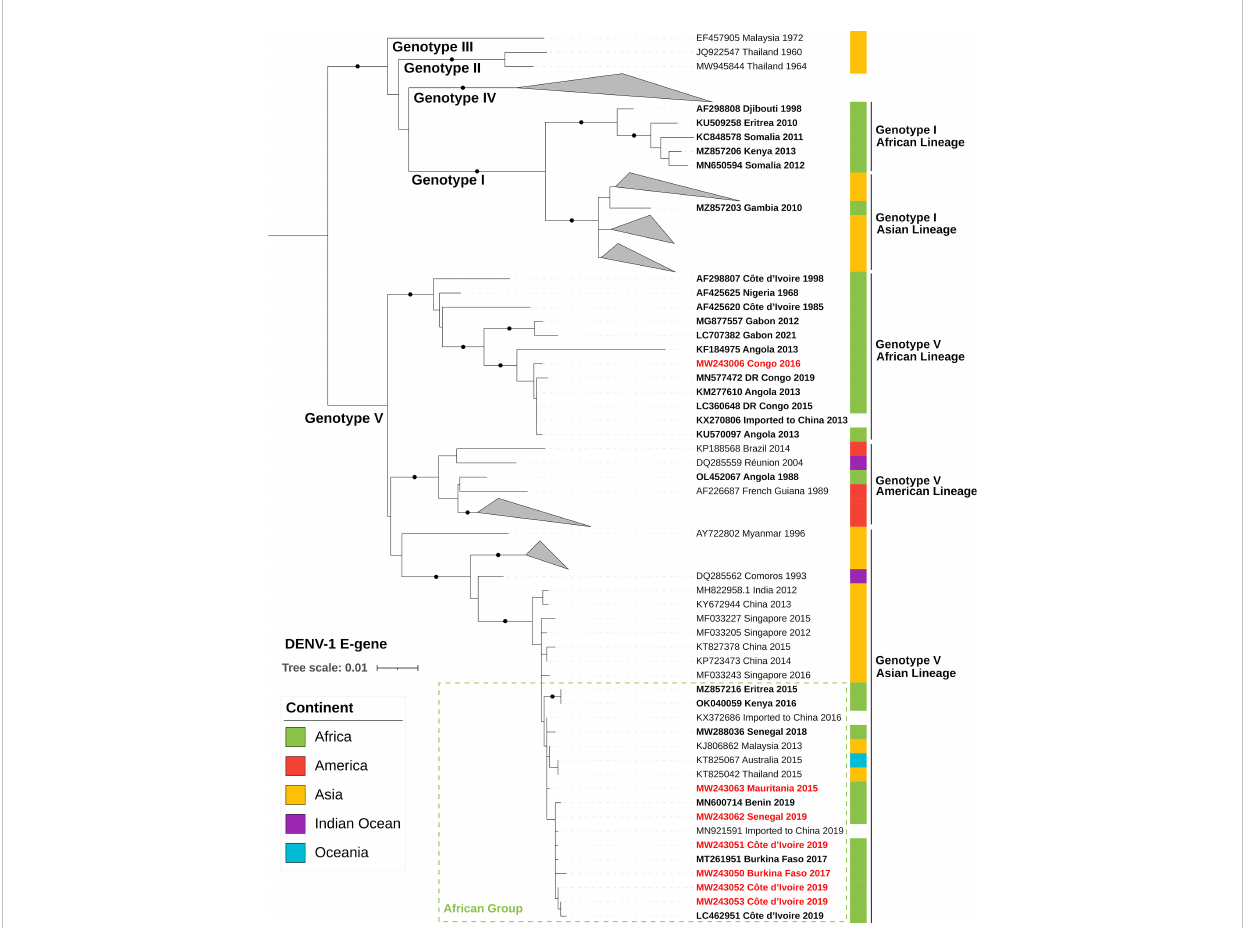
FIGURE 2 ML phylogenetic tree based on 130 E-gene sequences of DENV-1 strains (1,464-nucleotide-long sequences after trimming). DENV-1 strains from African countries are indicated in bold and strains from our dataset are in red text. Each strain is identi fi ed by its GenBank accession number, country of origin, and year of sample collection. The tree was rooted at the mid-point and bootstrap values equal to 100% are indicated by a black circle on the branch. The scale bar indicates genetic distance (nucleotide substitutions per site). The color strip indicates location of infection. DENV, dengue virus; DR Congo, Democratic Republic of the